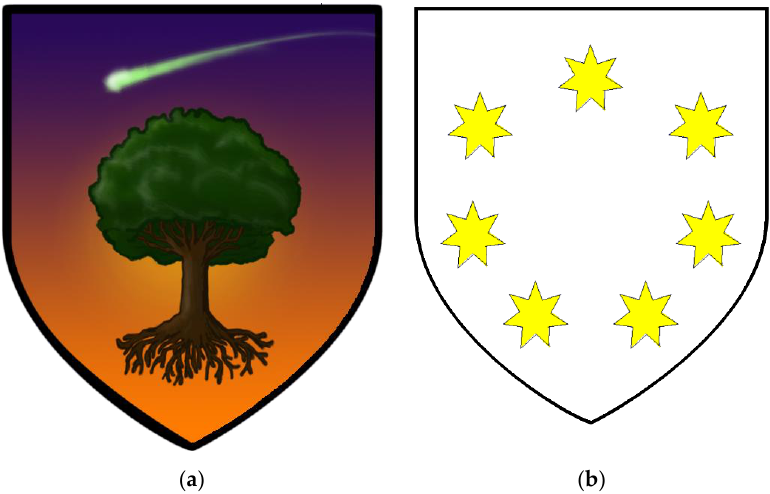
Figure 2. Distinctive tinctures and charges in Game of Thrones heraldry: ( a ) An interpretation of Ser Duncan’s oak tree and shooting star on a sunset field (A Wiki of Ice and Fire: Dunk.png 2015); ( b ) Metal on metal and seven-pointed stars of House Sunglass.